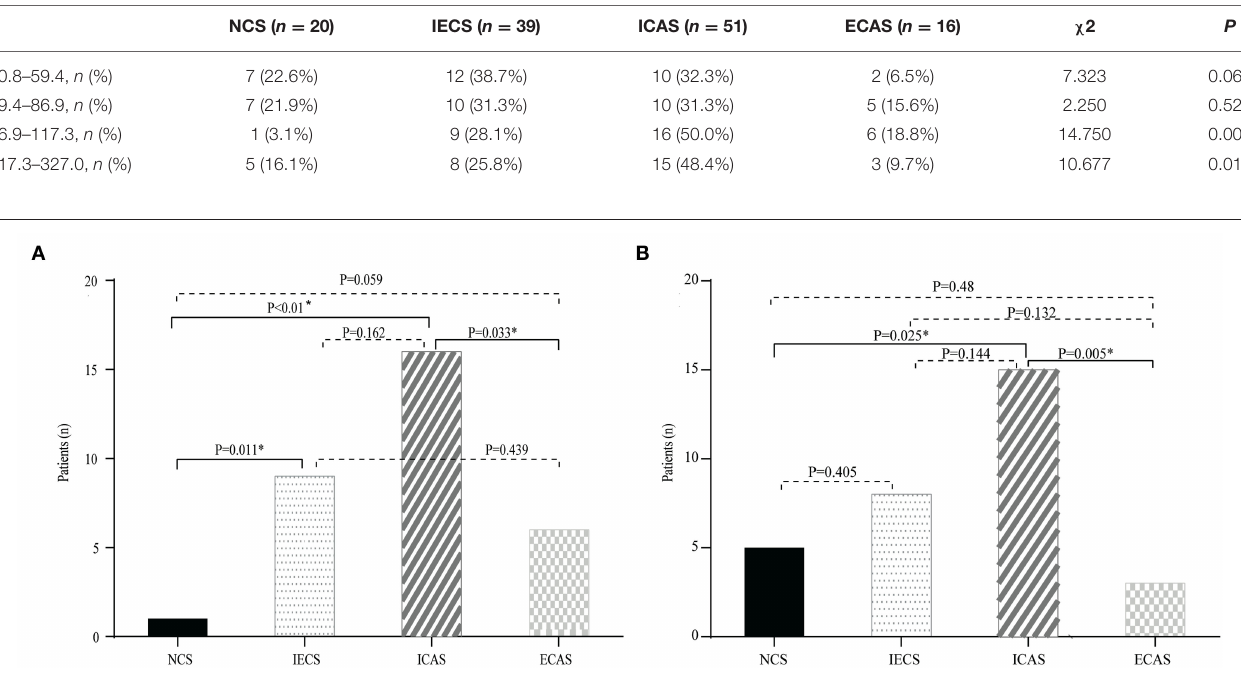
FIGURE 2 | Distribution of different stenosis subtypes in the third (A) and fourth (B) quartiles of Lp-PLA2. The prevalence of NCS, ICAS, extracranial artery stenosis (ECAS), and IECS according to the level of Lp-PLA2. There was a trend toward an increased risk of ICAS in the third and fourth